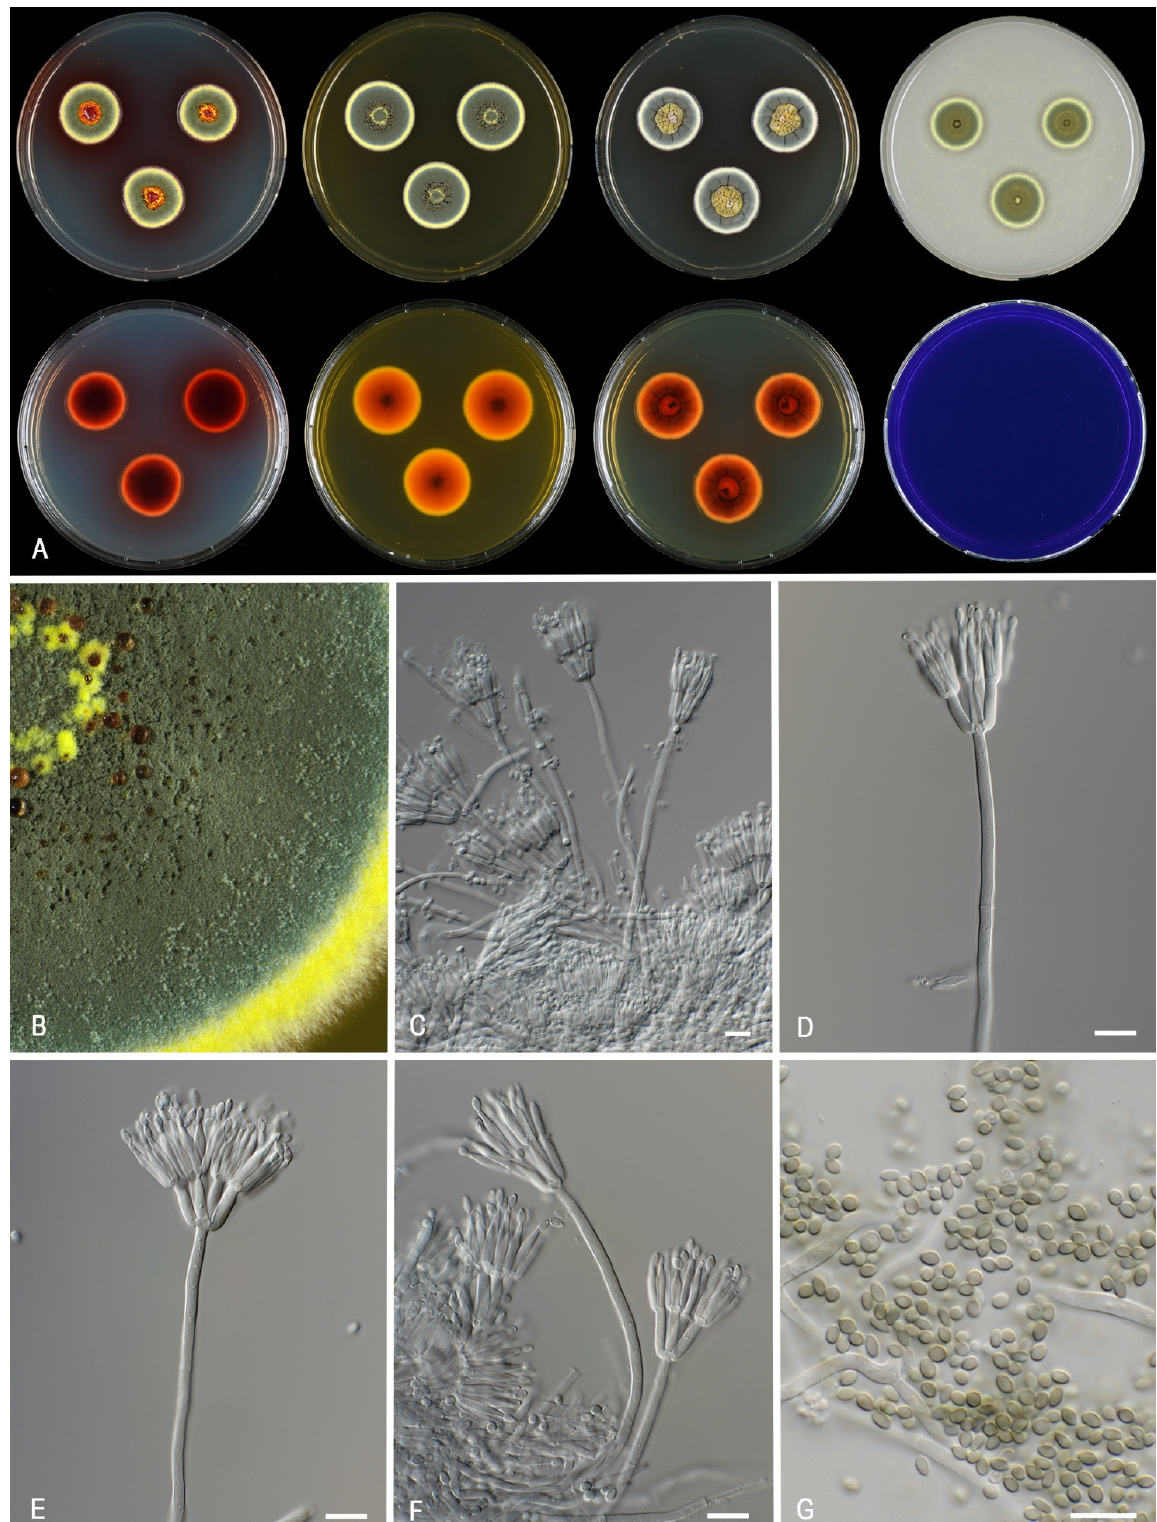
Figure 9. Morphological characters of Talaromyces germanicus (CBS 147314). ( A ). Colonies, from left to right, after 7 d at 25 °C (top row) CYA, MEA, YES, OA; (bottom row) CYA reverse, MEA reverse, YES reverse, CREA. ( B ). Detail of colony on MEA. ( C – F ). Conidiophores and conidia. ( G ). Conidia. Scale bars = 10 μ m.